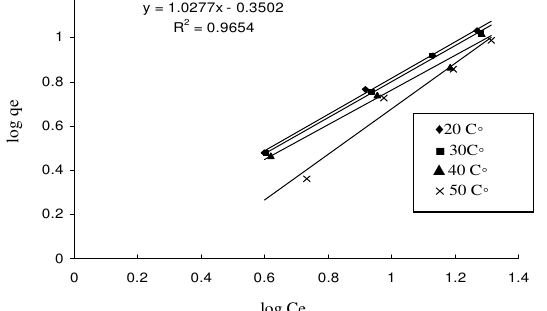
Figure 3. Freundlich plot for the adsorption of Cr(VI), 20, 30, 40 and 50 mg / L onto cinnamon 2 g/L.